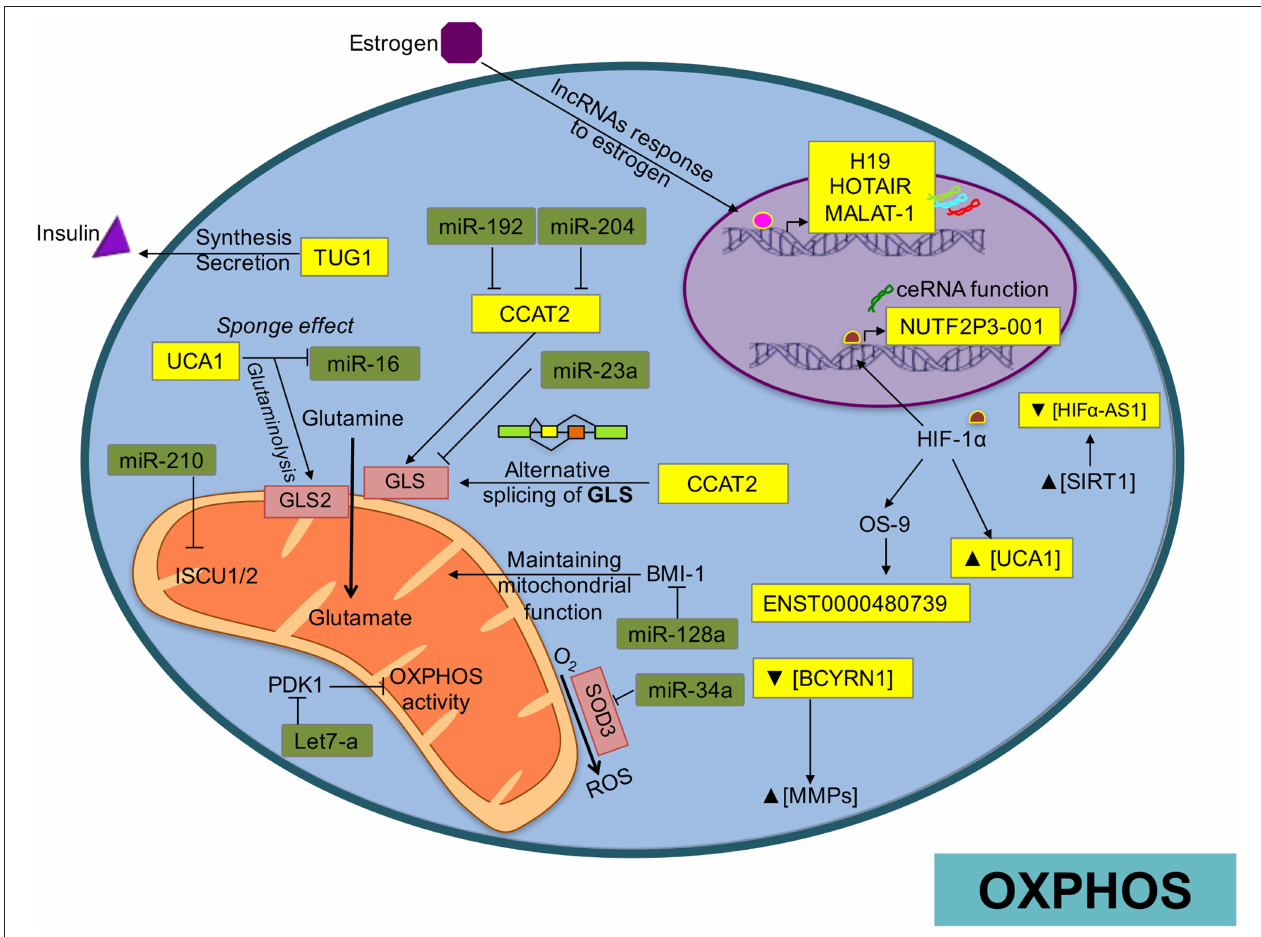
FIGURE 4 | Overview of ncRNA regulatory network over OXPHO in cancer. In this picture we show how ncRNAs are involved in the regulation of OXPHOS, generation of ROS, or mediating alternative splicing of mitochondrial